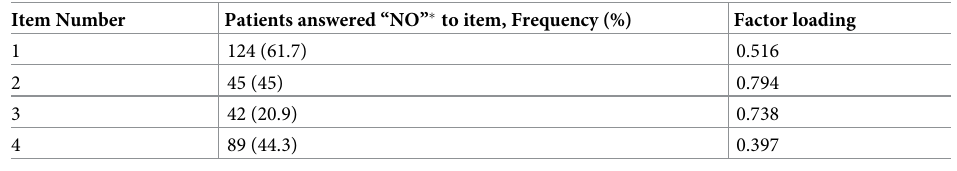
Table 5. Patients answers to items and maximum factors loading, N =